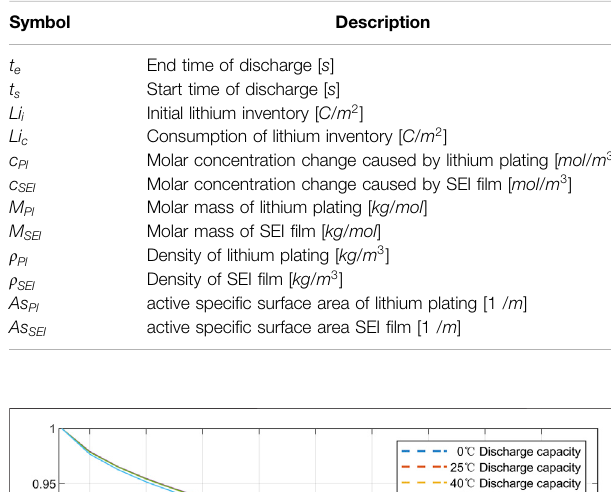
TABLE 4 | Parameters related to evaluation indicators.